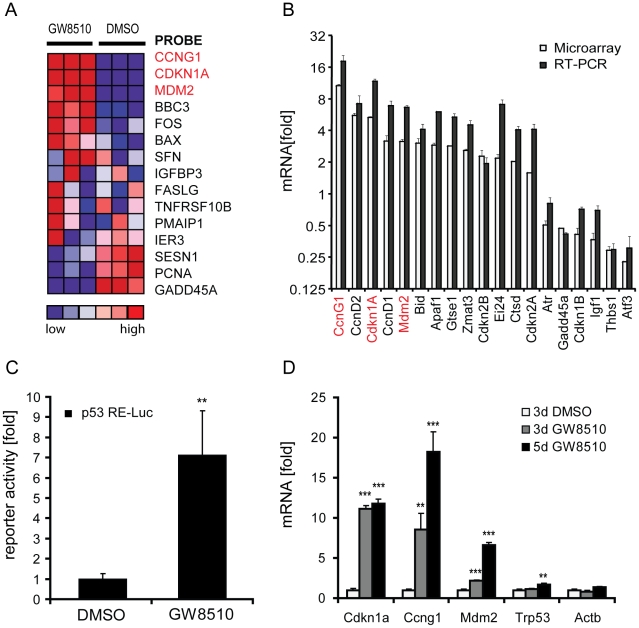
Involvement of the p53 pathway and quantification of p53 transcriptional activity and expression levels of p53 target genes following GW8510 treatment of alpha cells.(A) Heat-map display of one of the enriched gene sets (INGA_p53_TARGETS) in gene-expression profiling of alpha cells treated with 3.3 µM GW8510 for five days. Relative expression values in three biological replicates are plotted by color. Red, high expression levels, blue, low expression levels. (B) Reproducibility of gene-expression changes following GW8510 treatment, measured by microarray and qPCR. (C) Cellular p53 activity measured using a dual-luciferase reporter system. Activity of the firefly luciferase p53-reporter construct was normalized to constitutively active co-transfected Renilla luciferase, and to positive and negative controls. (D) qPCR measurement of transcript levels of direct p53 targets following 3- and 5-day treatments with 1.65 µM GW8510. Data represent the mean±SD of at least three experiments; **p<0.01 and ***p<0.001.